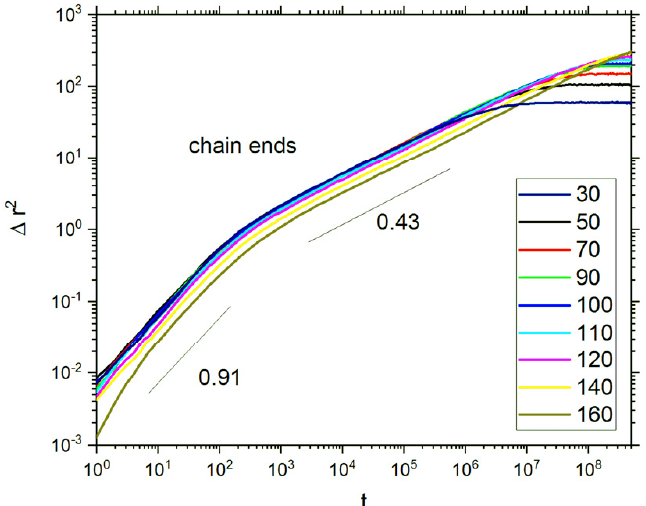
Figure 10. Mean squared displacement of chain ends as a function of time. The degrees of polymer- ization DP n are given in the inset. The case of σ = 0.3.